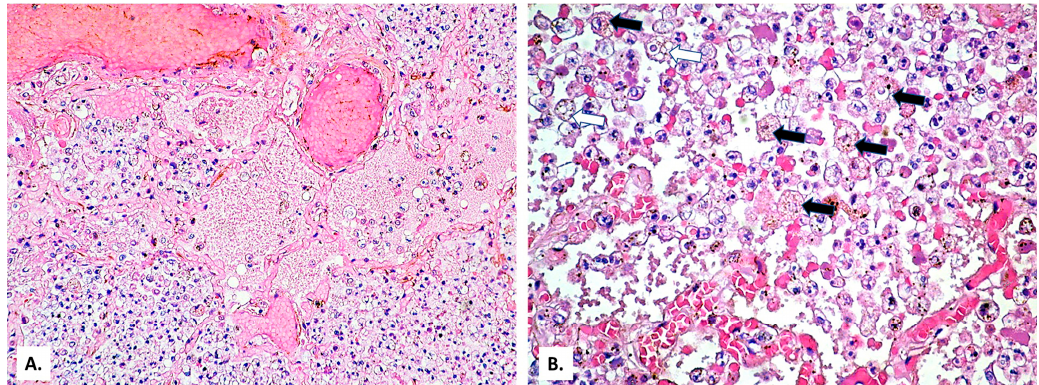
Figure 6. ( A ) Zonally different aspects of alveolar exudate (HE × 100). ( B ) Alveolar exudate rich in foamy macrophages (black arrows) and cystic forms (white arrows) (HE × 400).